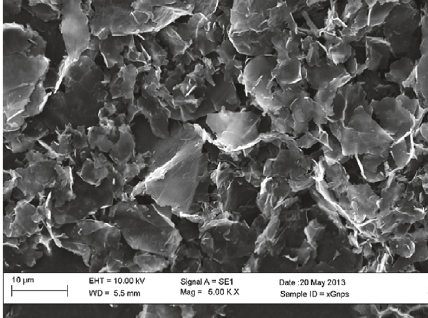
Figure 4: SEM image of